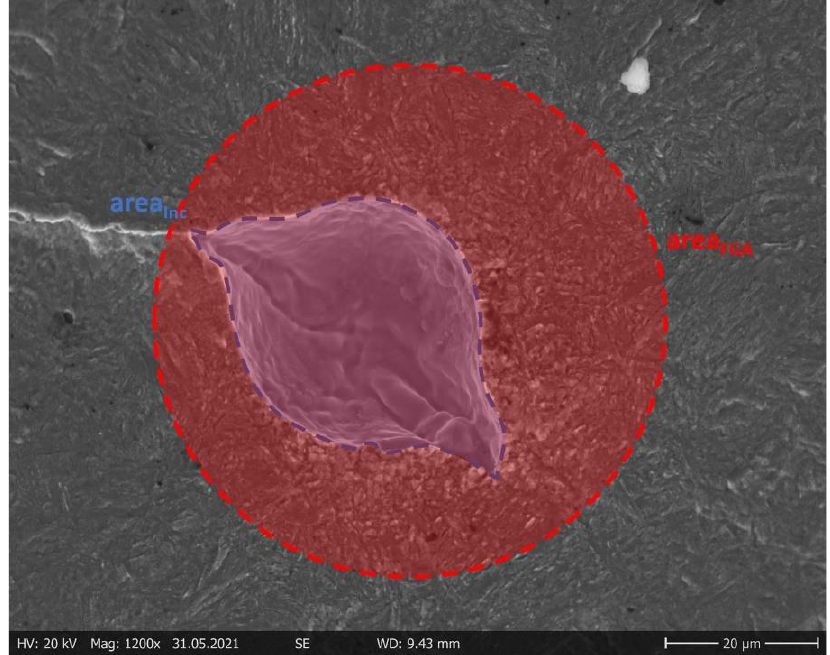
Figure 8. Crack initiation on the internal inclusion with a pronounced FGA formation (TMT σ a = 755 MPa, N f = 82,557,794 cycles) and the areas used for calculation of K max,Inc (blue-marked are of the inclusion) and K max,FGA (red-marked are of the area of inclusion plus FGA).